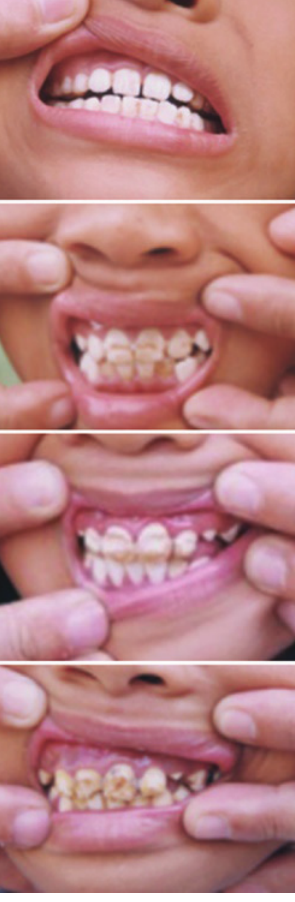
Figure 13: Images of children aged 7–15 having fluorosis: